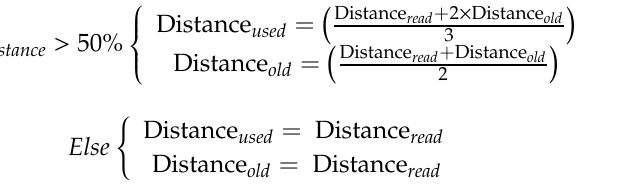
Figure 4. Inertial measure unit ( IMU) sensor in prototype. Manual Drive To detect the action of the user on the device, FSR 400 force sensors [39] were used. This type of sensor was chosen because of its low cost, particularly when compared with torque sensors. In total, six FSR 400 sensors were used. These sensors were positioned on the handle of the device, as depicted in Figure 5. The force sensors identified as FSR1 and FSR2 are responsible for detecting whether the user is holding the device with both hands. If one of the sensors does not capture a minimum force of the user, the operation of the engines is interrupted and blocked. This value of the minimum force required is obtained empirically by recording the sensor reading when the user holds the prototype handle firmly. Figure 5. Distribution of FSR 400 sensor at the prototype. The FSR3 and FSR4 sensors, shown in Figure 5, are the interfaces for direct user actuation on the left and right motors, respectively. Therefore, if the user exerts a force above a threshold on one of the actuation sensors, a velocity value proportional to the perceived force above this threshold is sent